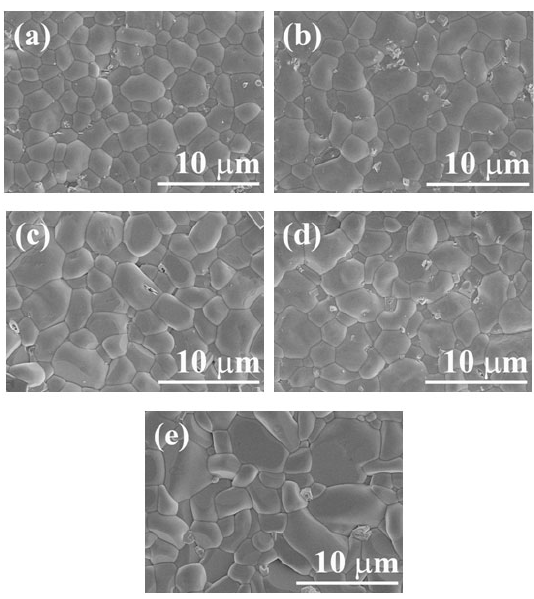
Fig. 5 SEM microphotographs of the CZMAT ceramics sintered at 850 ℃ for 6 h: (a) x = 0.02, (b) x = 0.04, (c) x = 0.06, (d) x = 0.08, and (e) x =